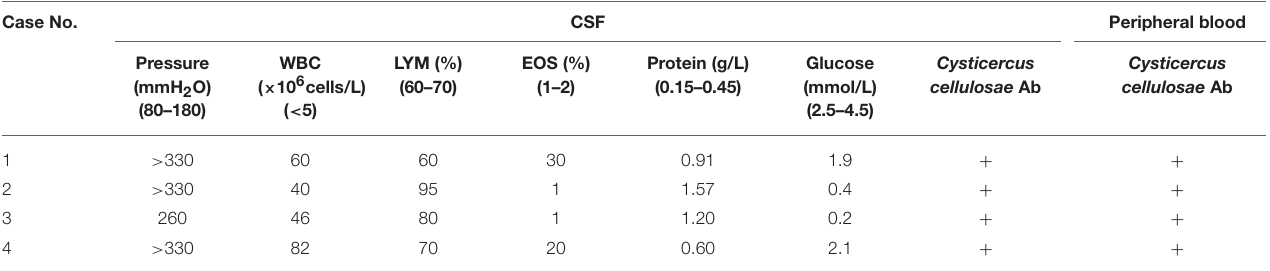
TABLE 2 | Laboratory features of the four patients with neurocysticercosis. Case No.